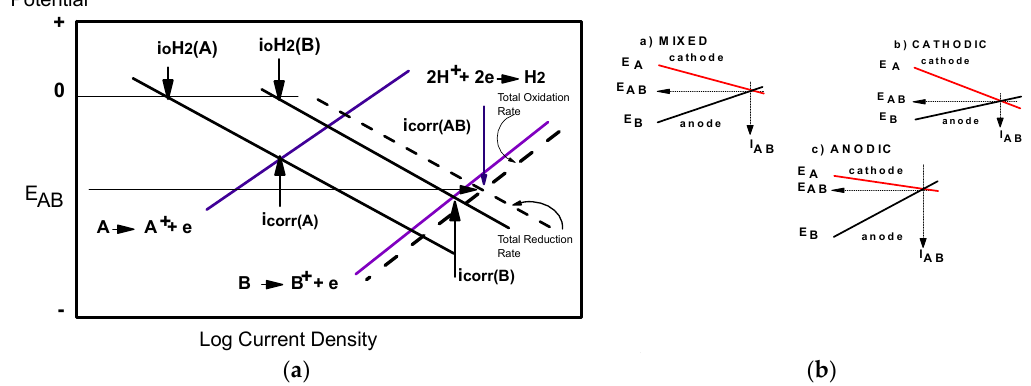
Figure 2. ( a ) Potential-current relationships for the case of a galvanic couple between two corroding metals. A: more noble metal; B: less noble metal [35].( b ) Effects of polarization on metal potential